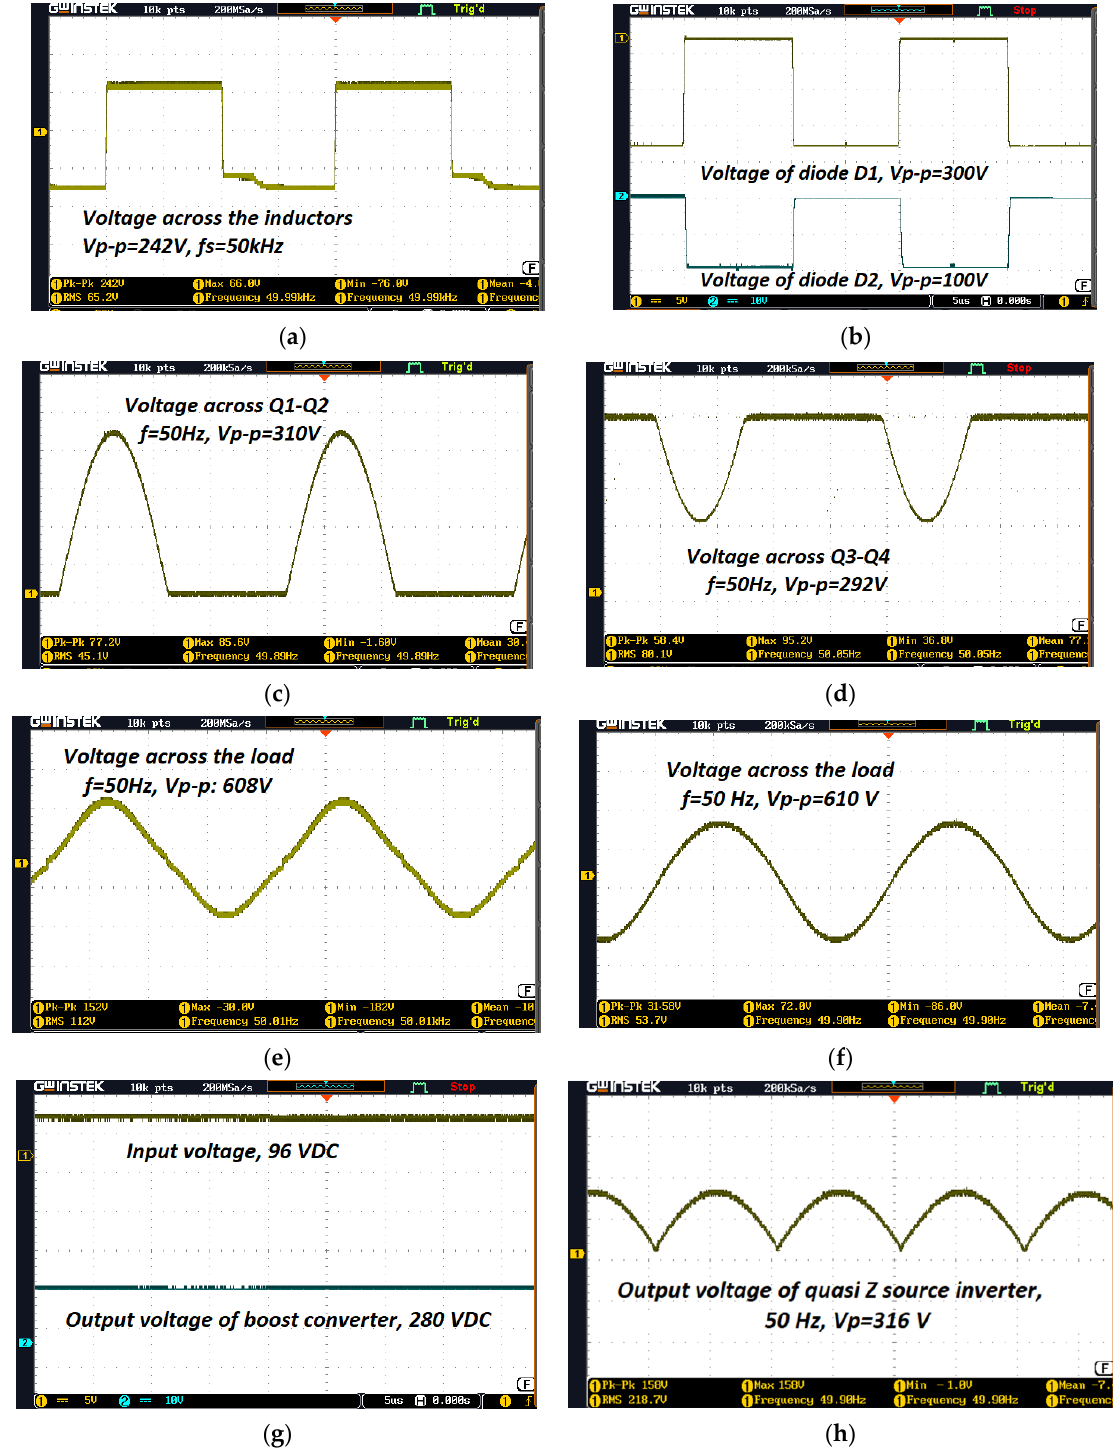
Figure 22. Test results: ( a ) voltage of inductors L1 and L2; ( b ) voltages of diodes D1 and D2; ( c ) voltages across the transistors Q1 – Q2; ( d ) Q3-Q4, output voltage under ( e ) resistive – inductive; ( f ) resistive loads; ( g ) input – output voltages of boost converter; ( h ) output voltage of quasi Z-source inverter.